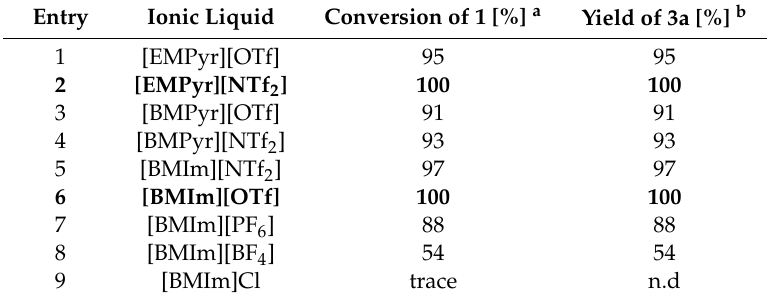
Table 1. Borylative coupling of vinylboronic acid pinacol ester ( 1 ) with styrene ( 2a ) in the presence